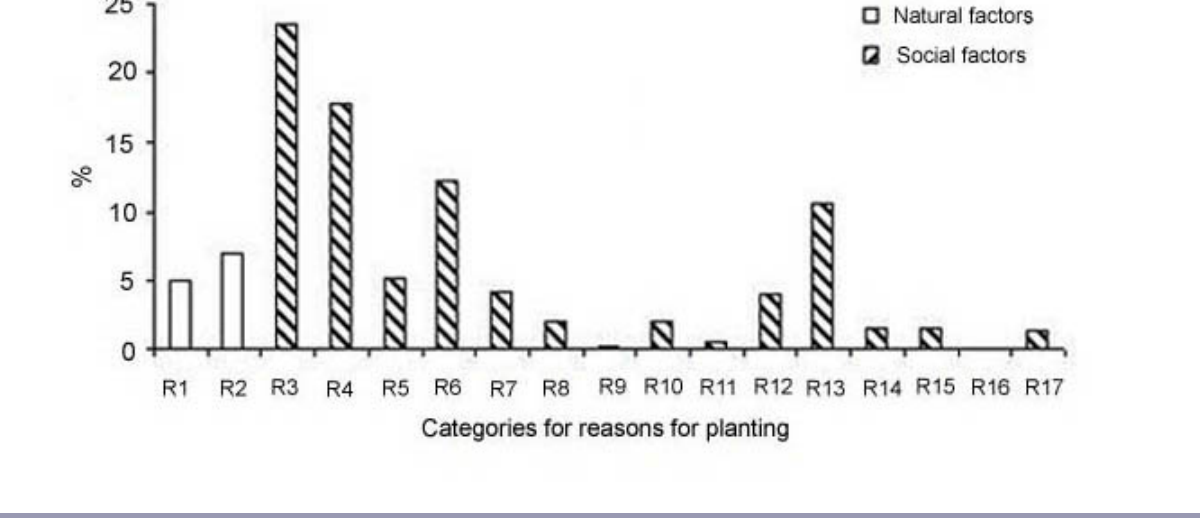
Fig. 3. Frequency distribution of categories for reasons given for planting by natural and social factors over the entire gradient. R1: regional character; R2: resistance-adaptation; R3: esthetics; R4: donation- gift; R5: professional advice; R6: use; R7: propagation; R8: easy maintenance; R9: symbolism; R10: imitation; R11: remembrance; R12: specific flowering; R13: previous presence in garden; R14: past experimentation; R15: change; R16: usefulness for another plant; R17: